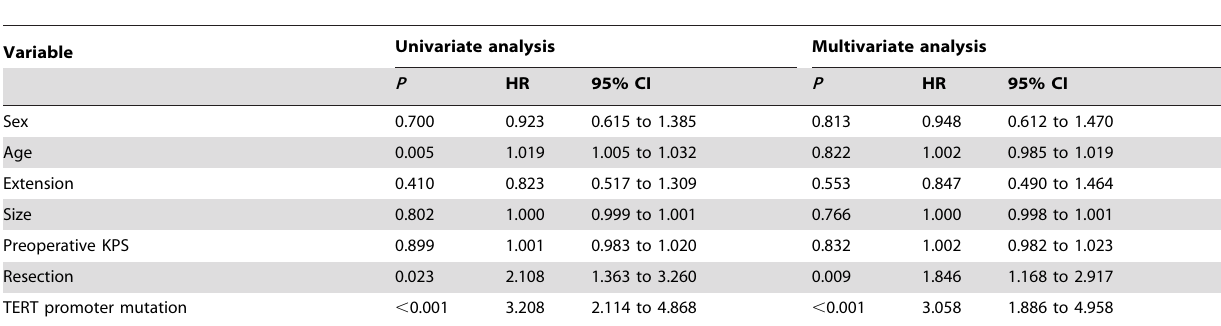
Table 3. Univariate and Multivariate Analysis of Different Prognostic Parameters for Overall Survival of Astrocytoma Patients.